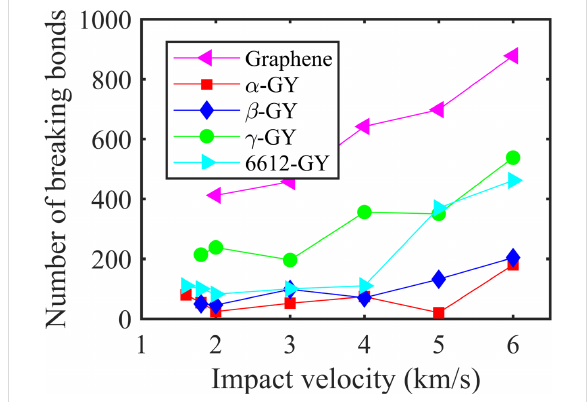
Figure 6: Number of breaking bonds in GY and graphene nanosheets under different impact velocity amplitudes.